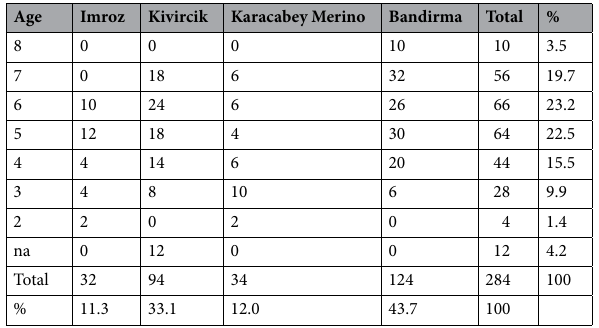
Table 5. Age and breed composition of the 142 matched pairs. na not